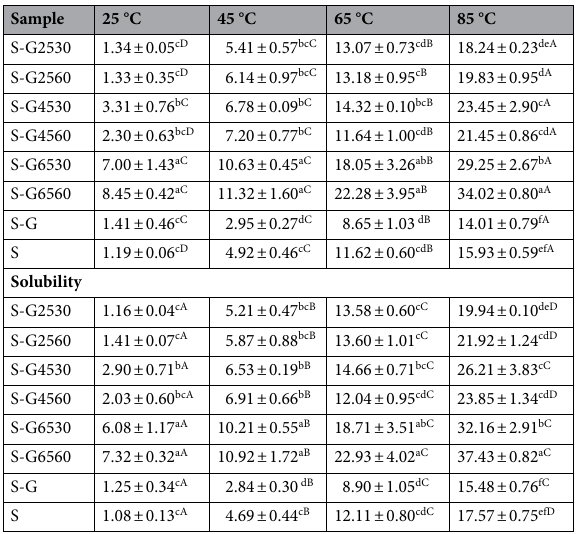
Table 2. Swelling power and solubility of thermal-ultrasound treated samples at 25, 45, 65, and 85 °C. a-f For each column, similar small code letters are not significantly different at p < 0.05. A-D For each row, similar large code letters are not significantly different at p <